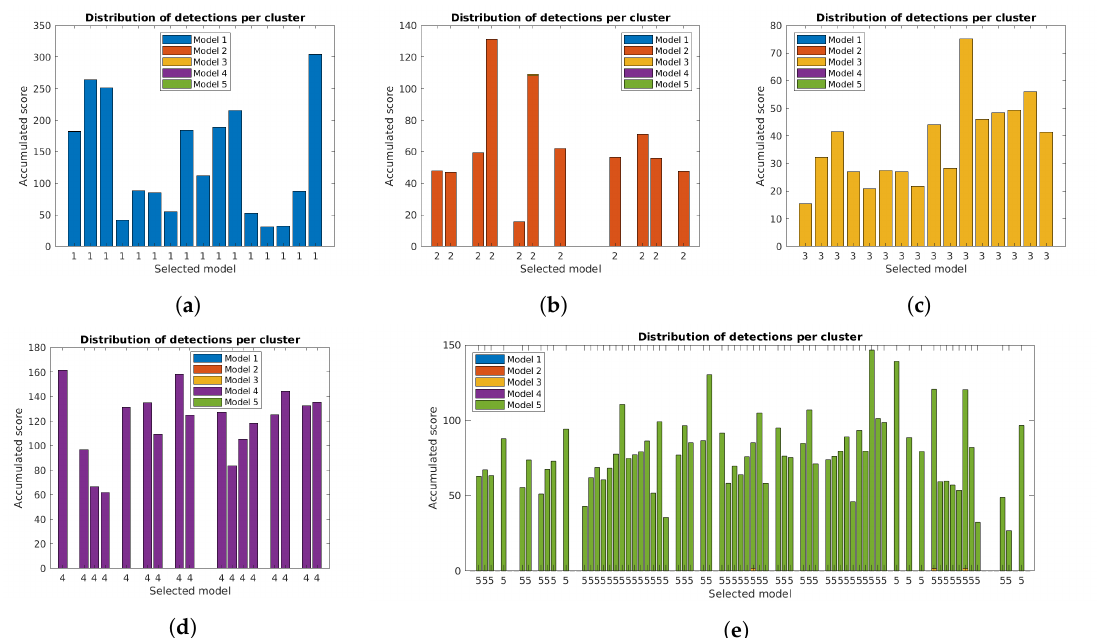
Figure 13. Accumulated scores for each lamp model in each cluster of the five case studies with filtering and orientation alignment. The model corresponding to the highest value is included below each bar: ( a – e ) Case studies 1 to 5.